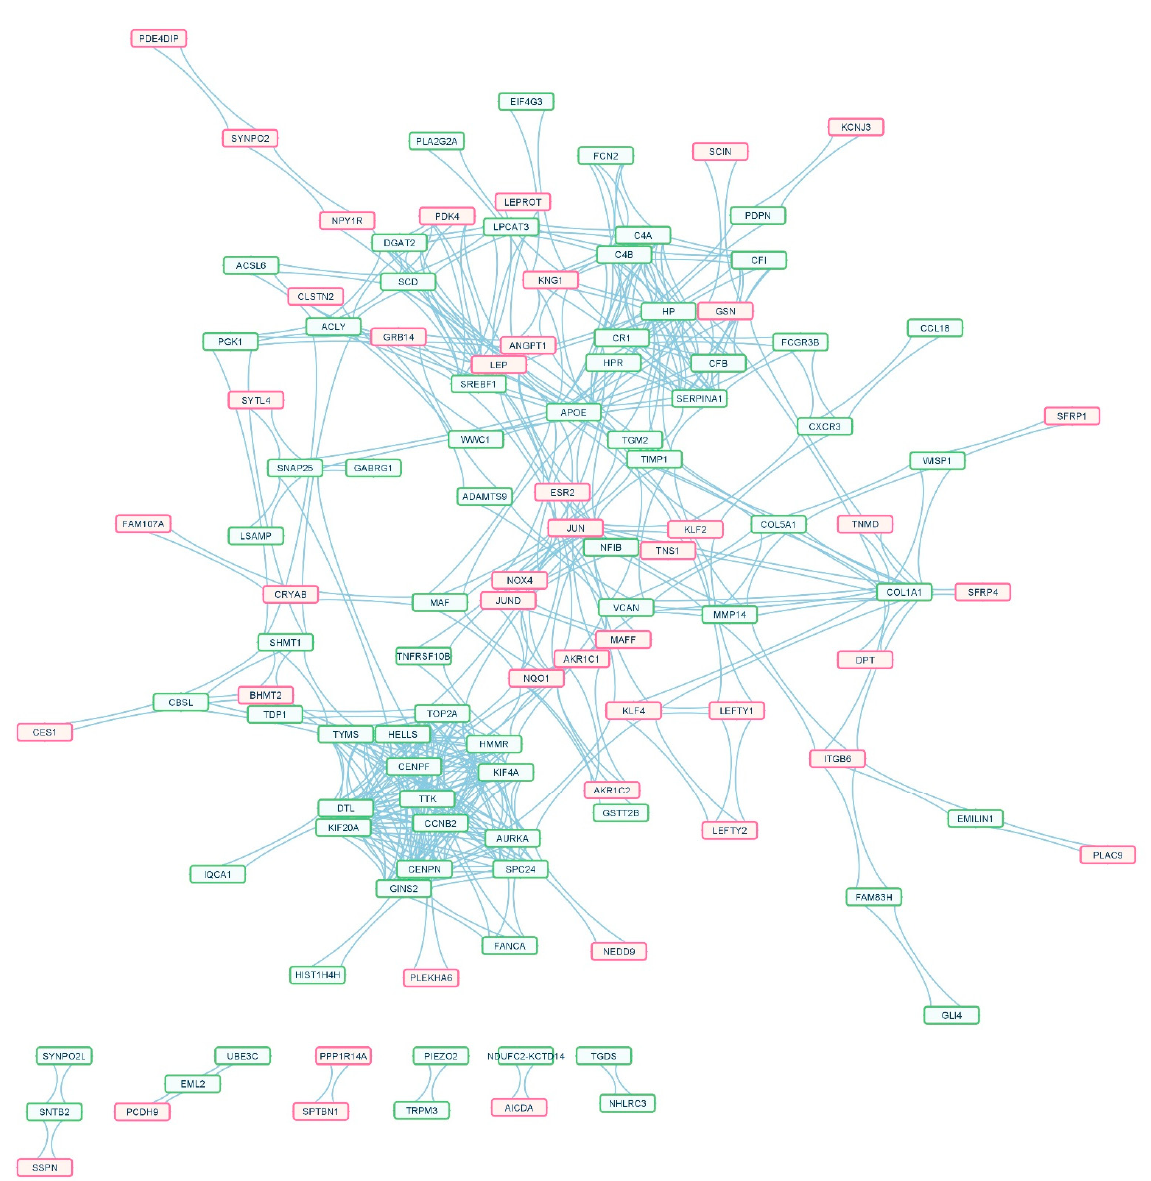
Figure 4. The protein–protein interaction (PPI) network of overlapping DEGs between obese and lean children. The red-purple border indicates the upregulated genes, and the green border shows the downregulated overlapping genes. There were 44 upregulated and 71 downregulated overlap- ping genes in the PPI network with 552 paired interactions.